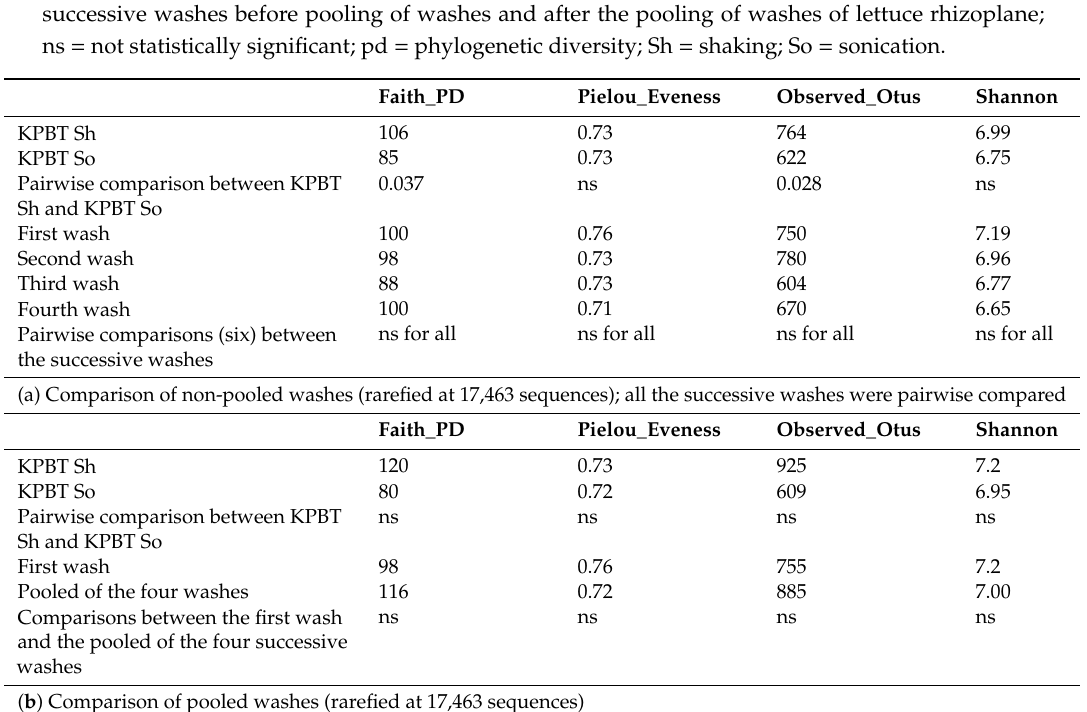
Table 4. Alpha diversity comparison (pairwise Kruskal-Wallis q -value) between the protocols, between successive washes before pooling of washes and after the pooling of washes of lettuce rhizoplane; ns = not statistically significant; pd = phylogenetic diversity; Sh = shaking; So =